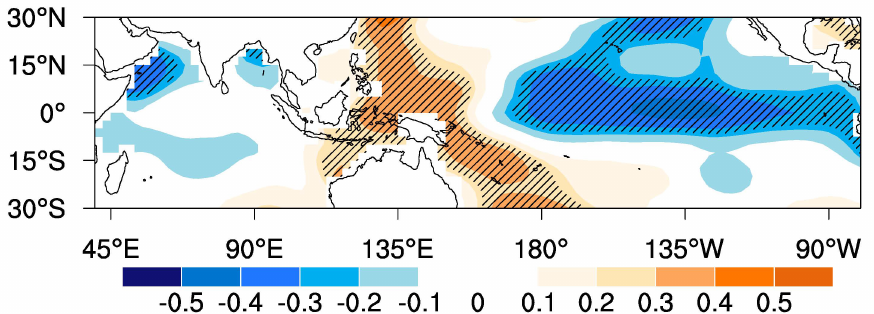
Figure 6. Correlation coefficients between the NPH index and SST anomalies during El Niño decaying summers. The shadow denotes the 95% confidence level for SST anomalies based on a two-tailed Student’s t